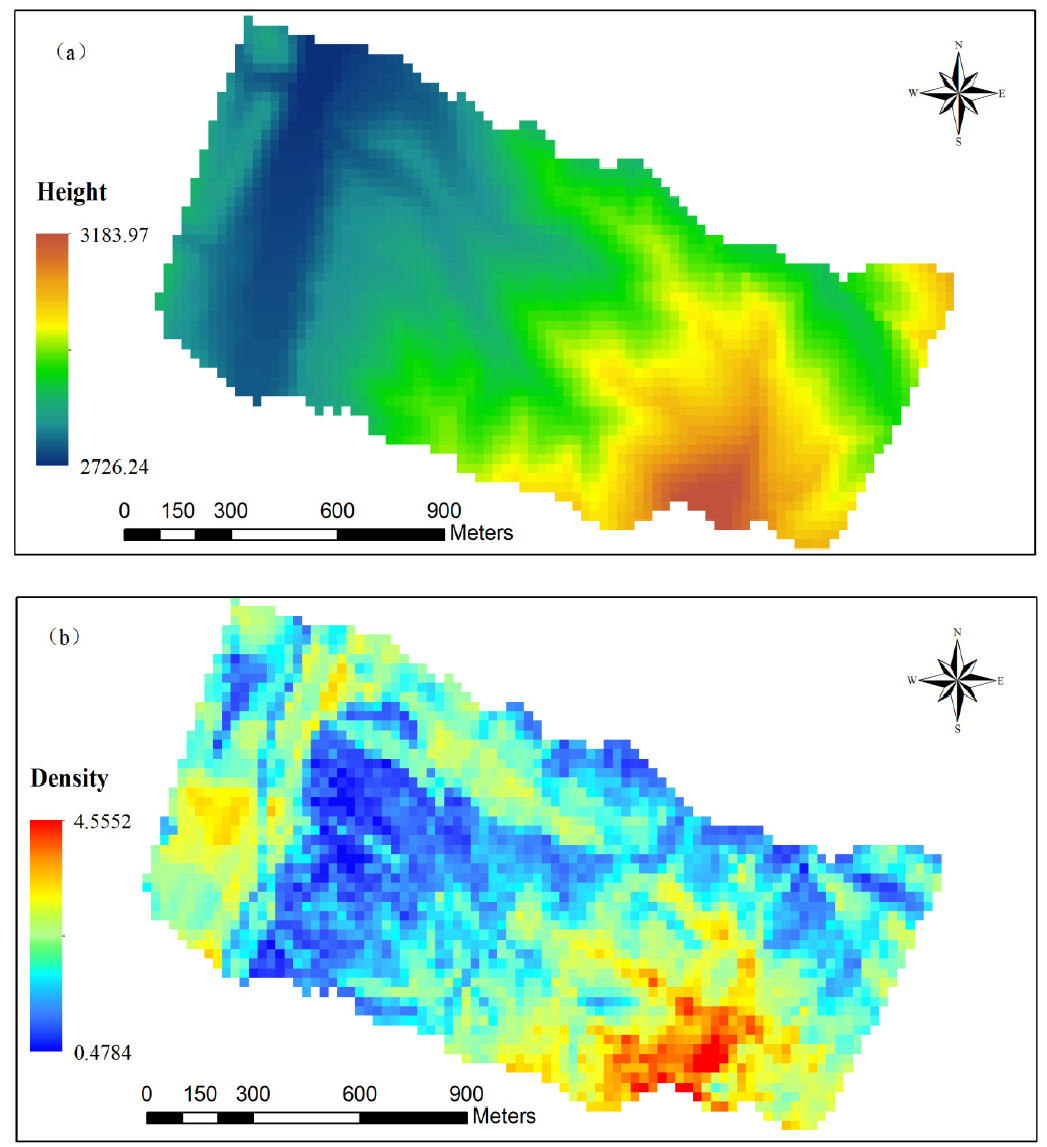
Figure 2. Spatial distribution patterns of the elevation ( a ) and density of laser points ( b ) on the study site.